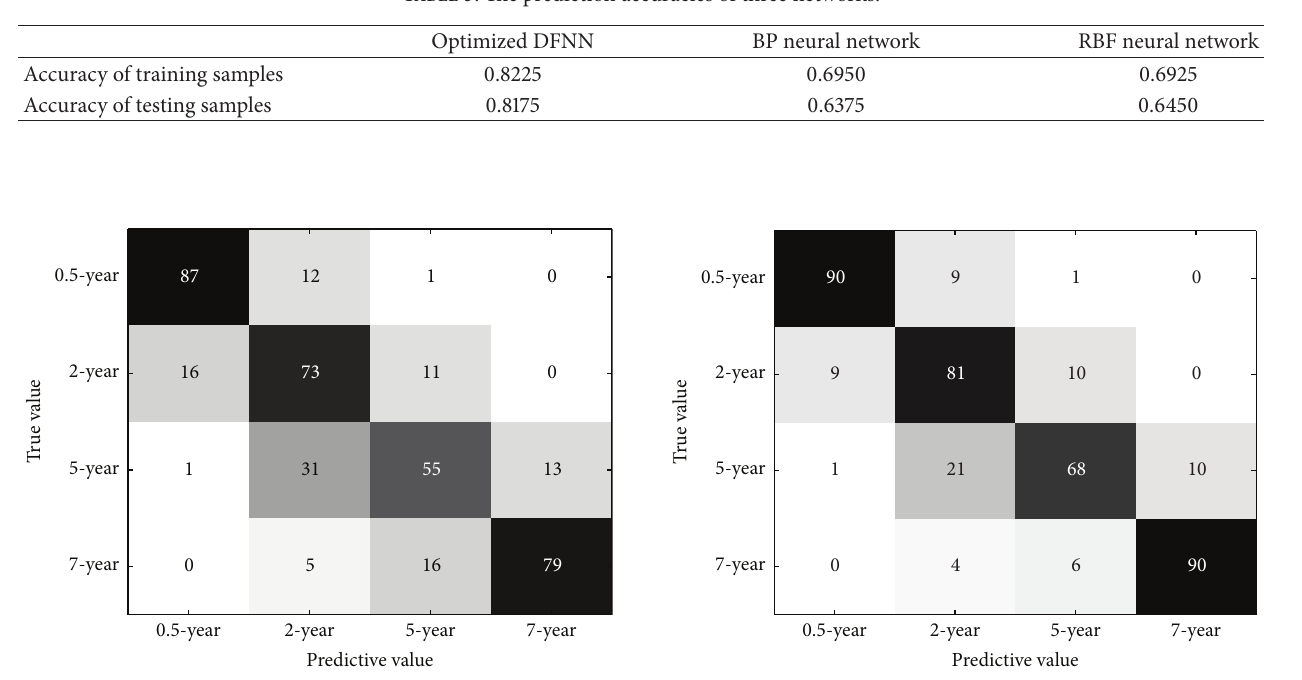
Figure 7: Unoptimized DFNN confusion matrix for training sam- ples.